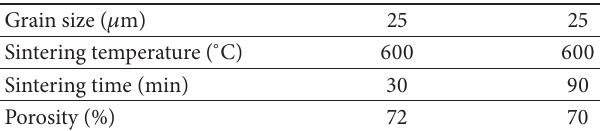
Table 4: Porosity of sintered structures from nickel powder with grain size of 25 𝜇